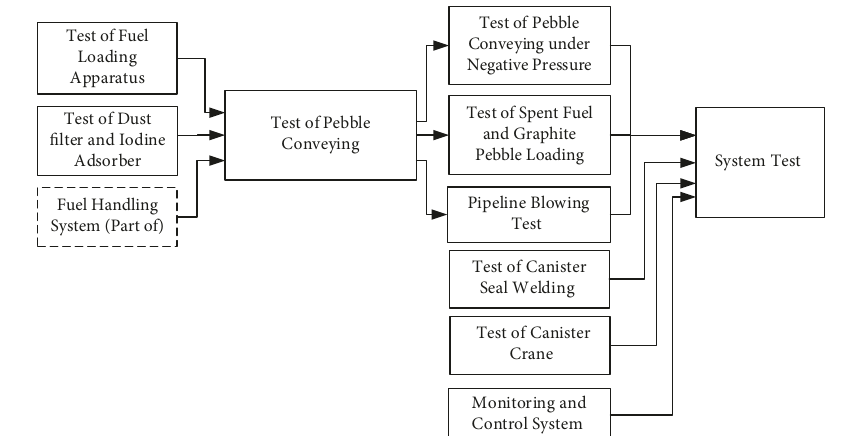
Figure 3: Flow diagram of the commissioning of